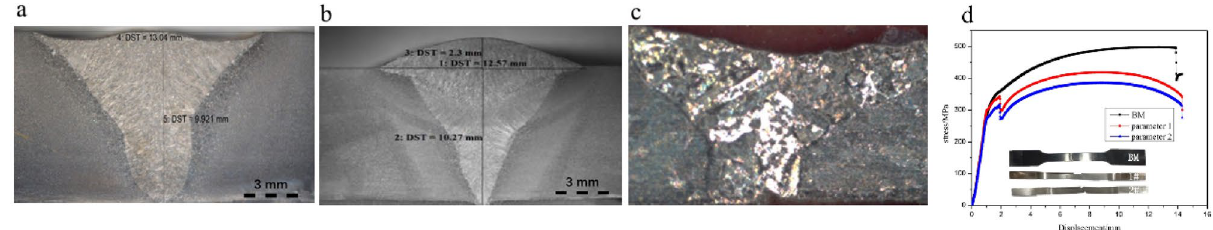
Figure 1. The macrostructure of welded joints. ( a ) Optical image of the sectioned area of the first parameter. ( b ) Optical image of the sectioned area of the second parameter. ( c ) The macrographs of the titanium welded joints. ( d ) The mechanical behavior of joints made of CP-Ti/Q235 bimetallic sheets in different